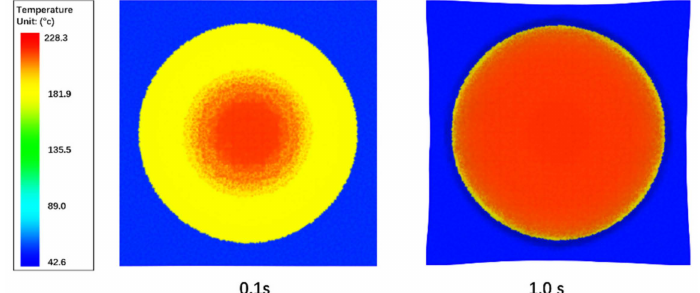
Figure 16. Temperature of the contact surface at 0.1 s and 1.0 s.